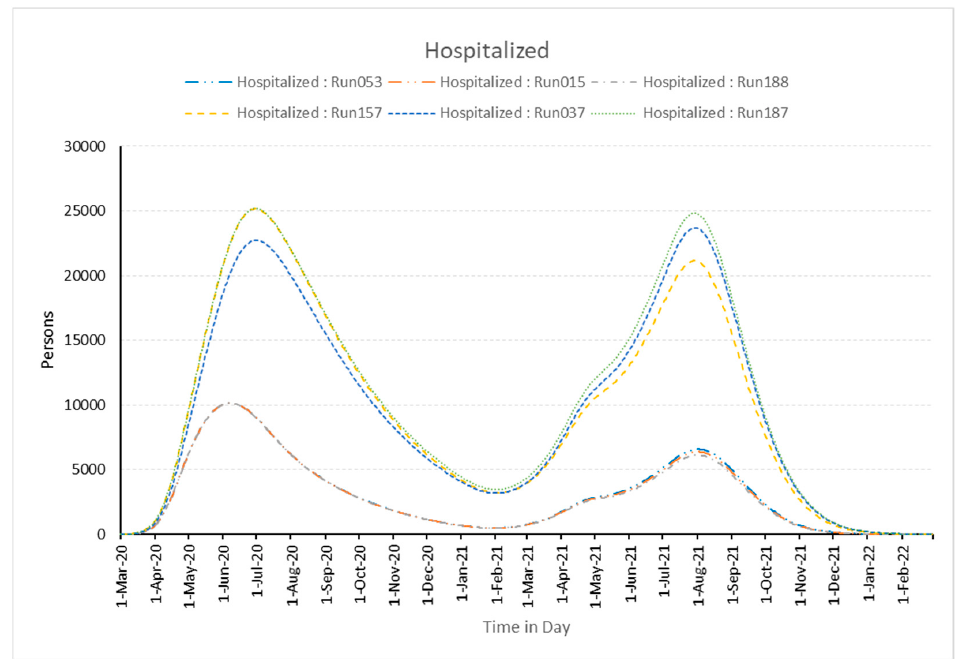
Figure 6. Number of persons hospitalized in simulation runs best-fitted runs (Run053, Run015, and Run188) and worst-fitted runs (Run037, Run157, and Run187).